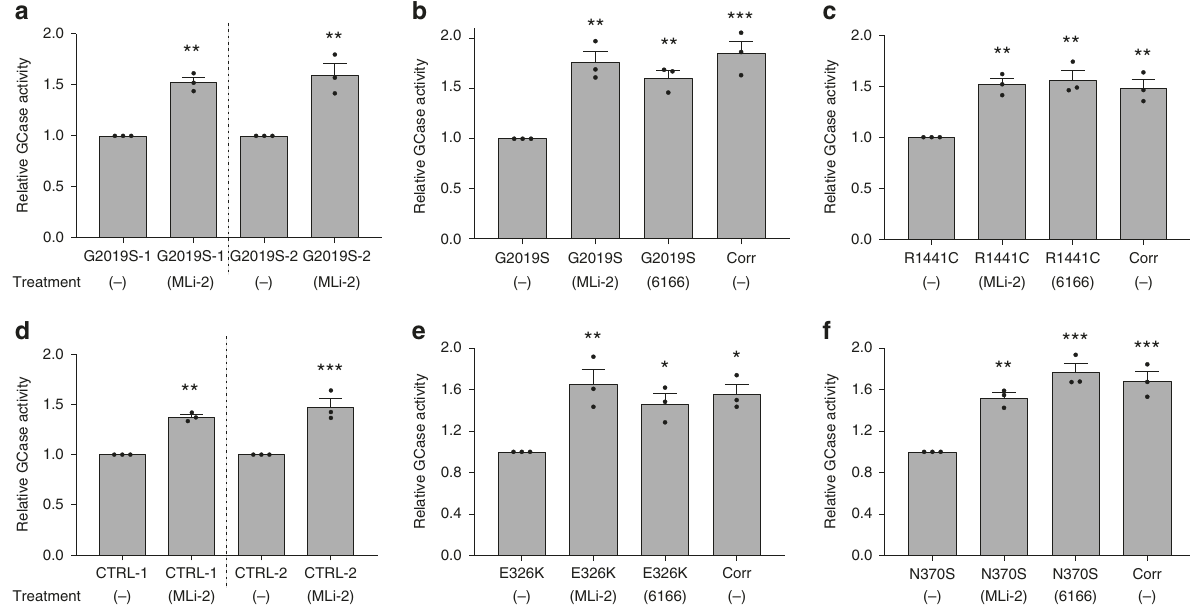
Fig. 2 Inhibition of LRRK2 kinase activity increases GCase activity in DA neurons from PD patients. Examination of lysosomal GCase activity in LRRK2 G2019S DA neurons treated with the LRRK2 kinase inhibitor, MLi-2 (600 nM) a . Comparison of GCase activity in LRRK2 G2019S b and R1441C c DA neurons relative to isogenic controls and neurons treated with MLi-2 or a direct GCase modulating compound, 6166 (3 µ M). GCase activity measured in DA neurons from two independent healthy controls treated with MLi-2 d . Comparison of GCase activity in GBA1 E326K e or N370S f DA neurons relative to isogenic controls and neurons treated with MLi-2 or 6166. The data are presented as the mean ± SEM, n = 3; * p < 0.05, ** p < 0.01, *** p < 0.001 relative to untreated, one-way ANOVA followed by Tukey ’ s multiple comparison post hoc test . Source data are provided as a Source Data fi le.